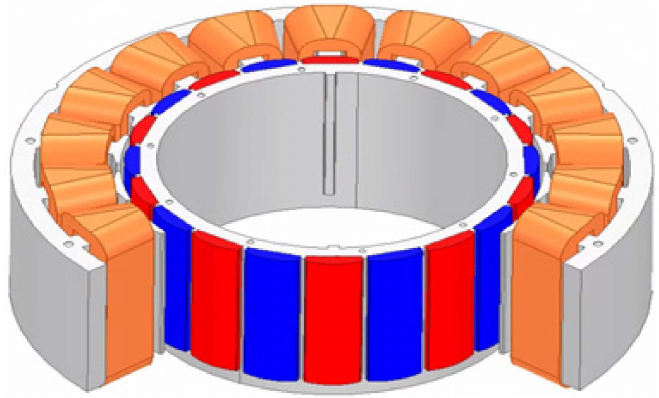
Figure 4. Joint robot and drive module components.